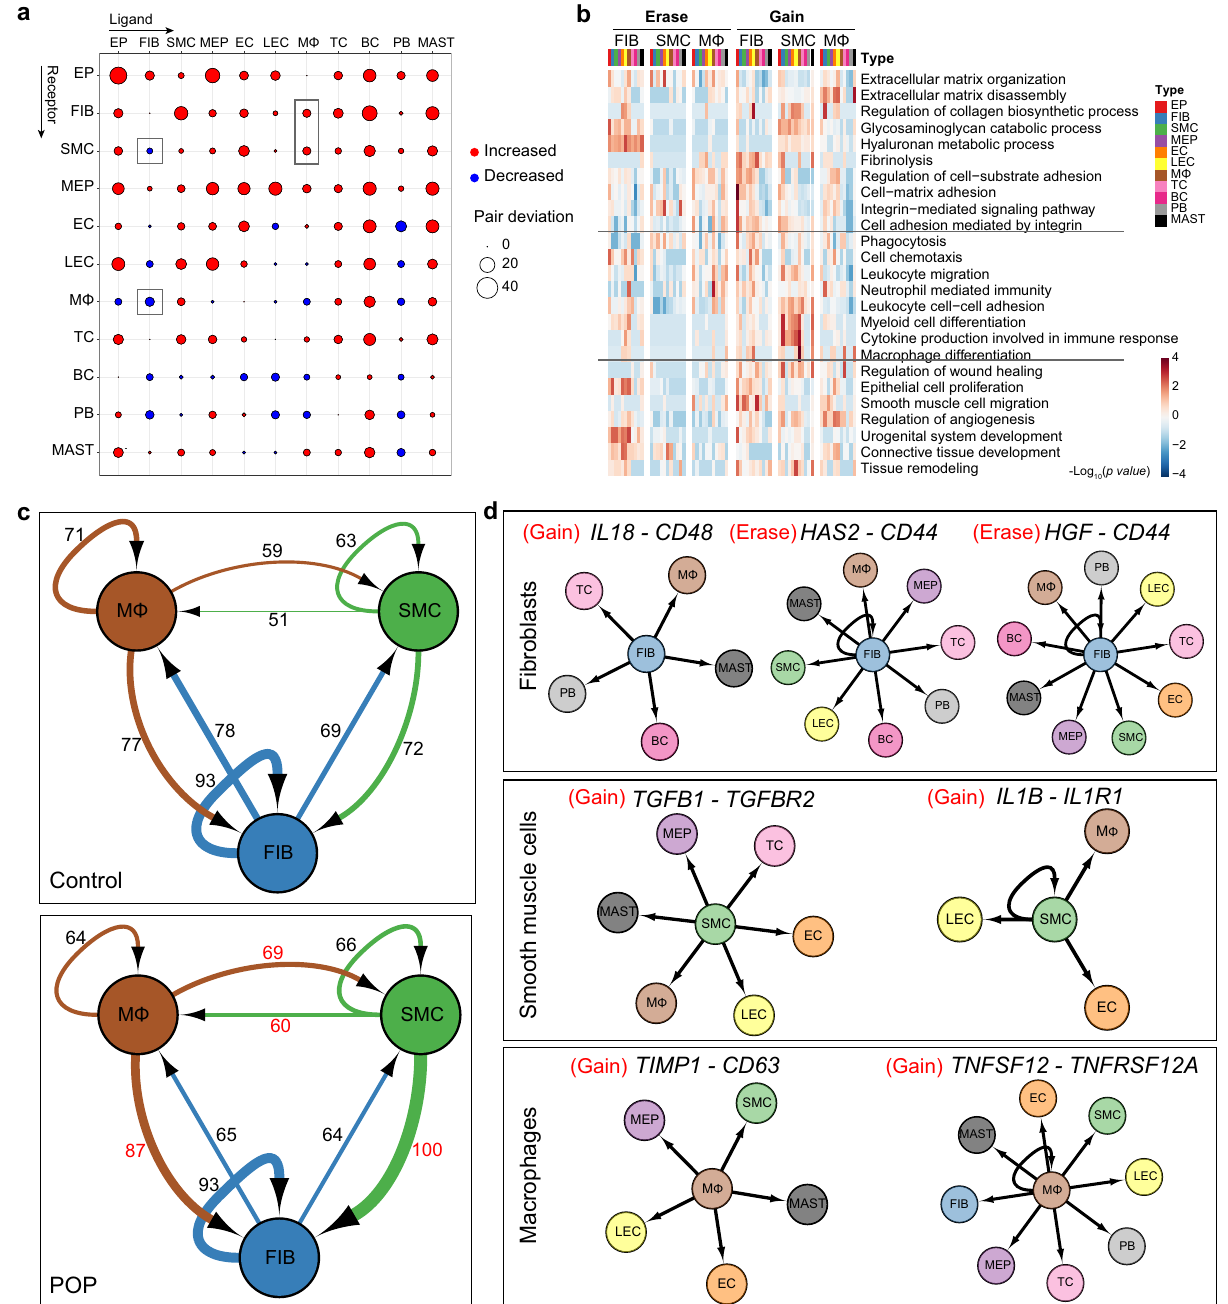
Fig. 4 Global analysis of ligand – receptor interaction pairs. a Dot plots depicts the changed numbers of putative ligand – receptor pairs in POP samples compared with control samples (red, increased; blue, decreased). b Heatmap displaying the gene ontology enrichment in the increased or decreased ligand – receptor pairs in fi broblasts, smooth muscle cells and macrophages. c Network visualization of ligand – receptor pair numbers among fi broblasts, smooth muscle cells and macrophages. The number of ligand – receptor pairs was shown. d Network visualization of speci fi c pairs among different cell types between control and POP samples. EP epithelial cell, FIB fi broblasts, SMC smooth muscle cells, MEP myoepithelial cells, EC endothelial cells, LEC lymphatic endothelial cells, M Φ macrophages, TC T cells, BC B cells, PB plasma B cells, MAST mast